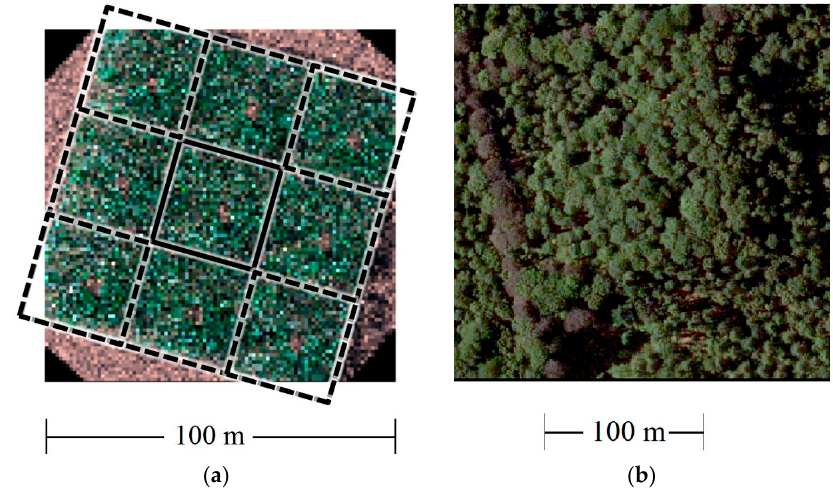
Figure 2. ( a ) Raytraced image (RGB) of the simulated forest in PBRT. The core area (black solid line) in the center, with eight neighboring cloned areas (black segmented line), can be seen; ( b ) An image from the real forest is also displayed. Source orthophoto: Informatie Vlaanderen.